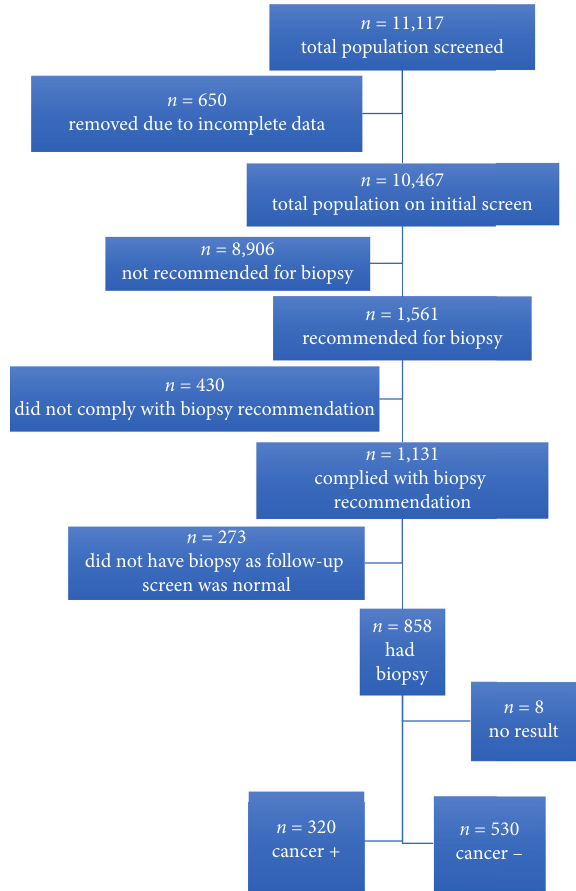
Figure 1: Consort flow diagram describing the progression of subjects through the